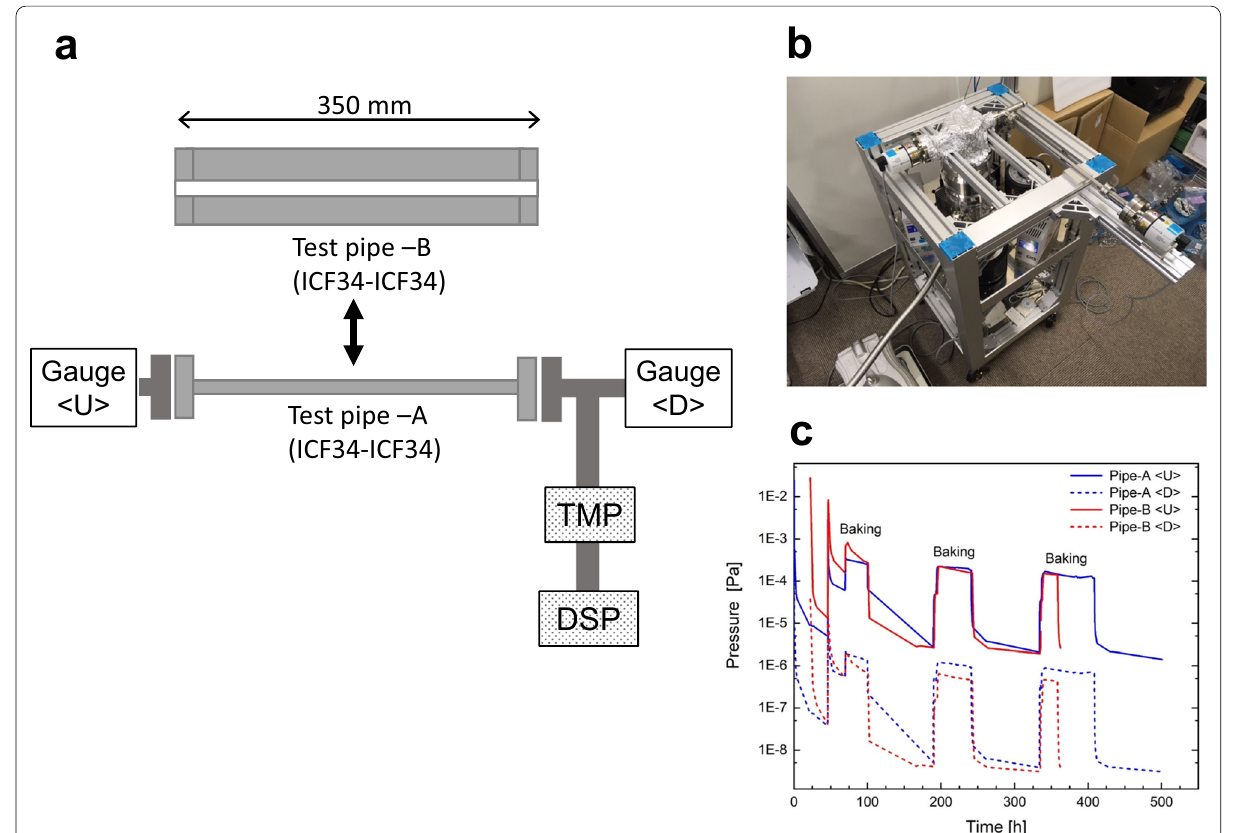
Fig. 3 Configuration and result for the preliminary experiment on vacuum testing using two types of pipes with two different wall thicknesses. The test pipe-A has a thin wall thickness of 1.65 mm, and the test pipe-B has a thick wall thickness of 14 mm. The inner diameters are 6.2 and 6.0 mm, respectively. a Configuration of the experimental system; b photograph of the experimental system, and c result of the vacuum pressures measured with the gauges < U > (upstream side) and < D > (downstream side), as shown in a , against evacuating time. Two pipes show similar